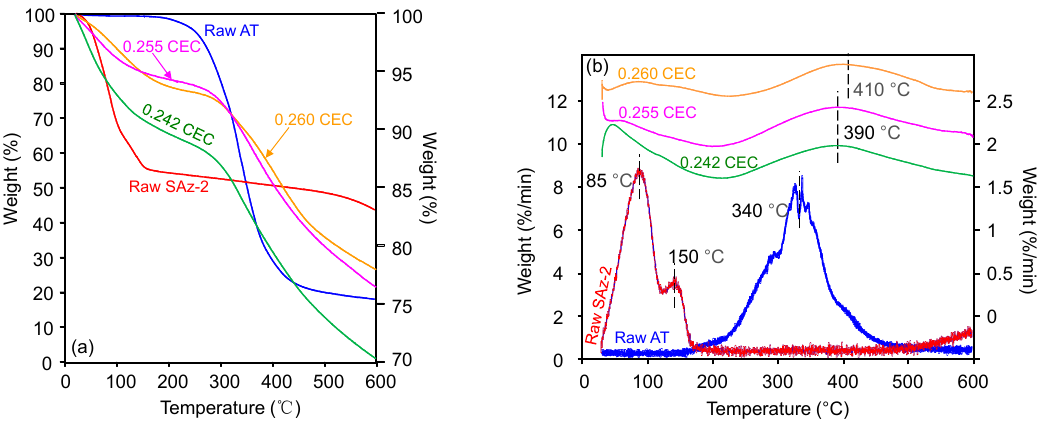
Figure 8. TG analyses of raw SAz-2, and SAz-2 with AT adsorbed amounts equivalent to 0.242, 0.255 and 0.260 CEC of the clay mineral ( a ); the vertical scale of figure for raw AT was on the left side, for the others were on the right side. Also drawn is the DTG analyses of them ( b ); the vertical scale of raw SAz-2 and SAz-2-AT were on the right side, and raw-AT was on the left side.